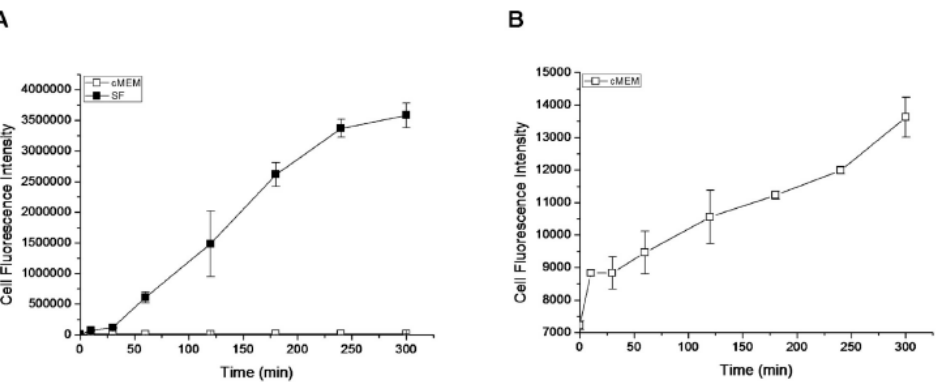
Figure 3. ( A ) Kinetics of cell uptake of fluorescently labeled silica NPs (25 µg/mL) in the complete (cMEM) and serum-free (SF) media, measured by flowcytometry; ( B ) curve in cMEM from A alone. Reprinted with permission from [77]. Copyright 2012 American Chemical Society.